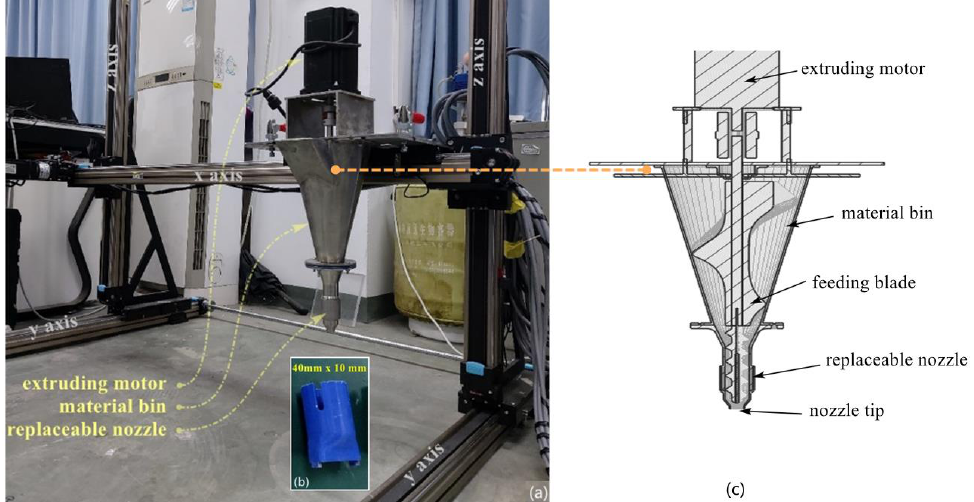
Figure 2. Three-dimensional printing device: ( a ) 3D printer with a round nozzle tip, ( b ) the rectan- gular nozzle tip of 40 × 10 mm, and ( c ) design of the printing head.